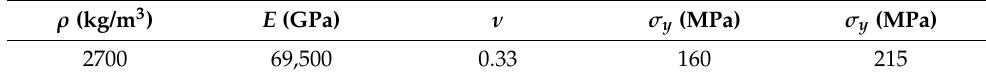
Figure 3. Load Model Distribution of Prior Study as a Validation Procedure. Table 1. Mechanical Properties of Aluminum Al6060.